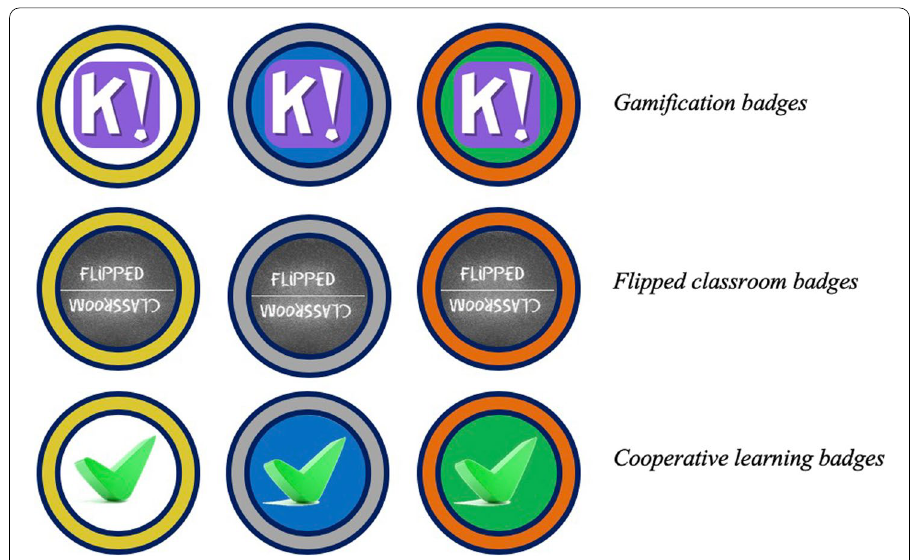
Fig. 6 The Badges of the Econplus Champions